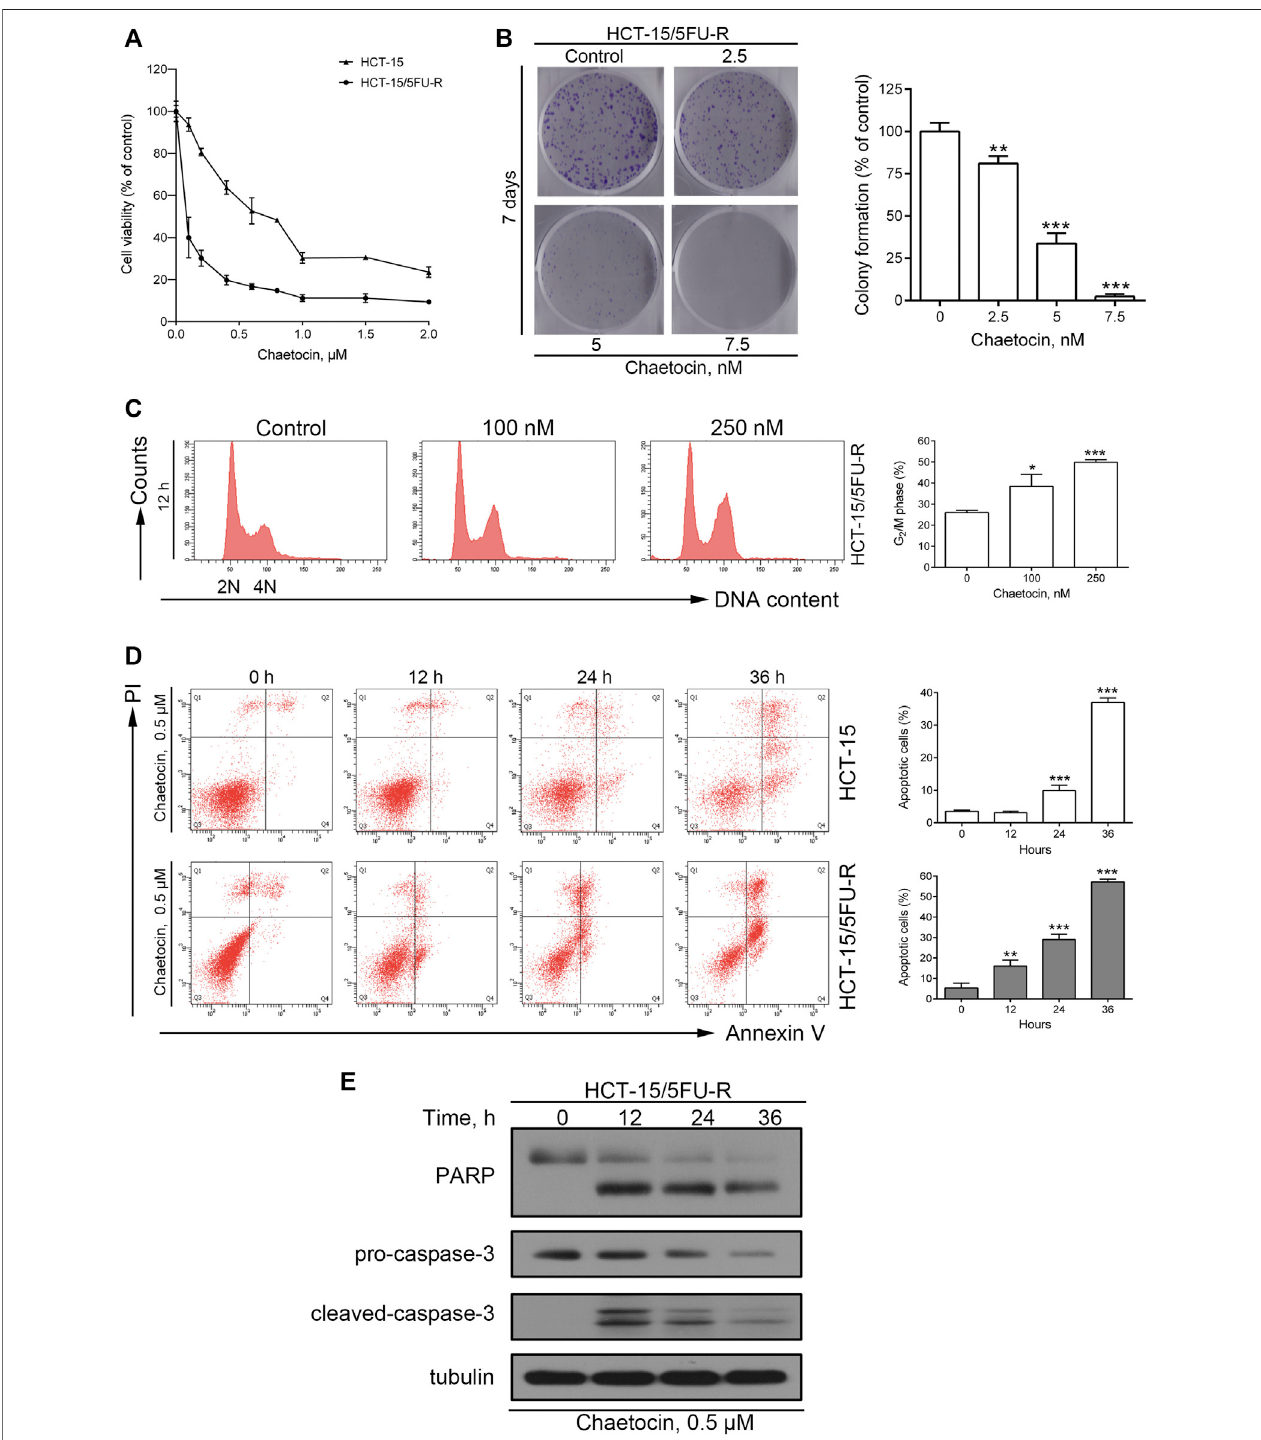
FIGURE5| Chaetocinovercomes5-FUresistanceinCRCcells. (A) TheCCK8cellviabilityassayon5-FUresistantandsensitiveHCT-15celllines. (B) After7 days chaetocintreatment,colonyformationresultofHCT-15/5FU-Rcells. (C) Cellcycledistribution resultsofHCT-15/5FU-Rcellsafter12 hchaetocintreatmentatindicated concentration were analyzed by fl ow cytometry with PI staining. (D) Apoptotic population analysis by fl ow cytometry with Annexin V-FITC/PI staining of HCT-15 and HCT-15/5FU-R cells, after 0.5 μ M chaetocin. (E) Western blot results on PARP and caspase-3 expression level in HCT-15/5FU-R cells. For a , (B) , (C) and (D) , results were shown as mean ± SD of three independent experiments. * p < 0.05, ** p < 0.01, *** p < 0.001, versus control group.